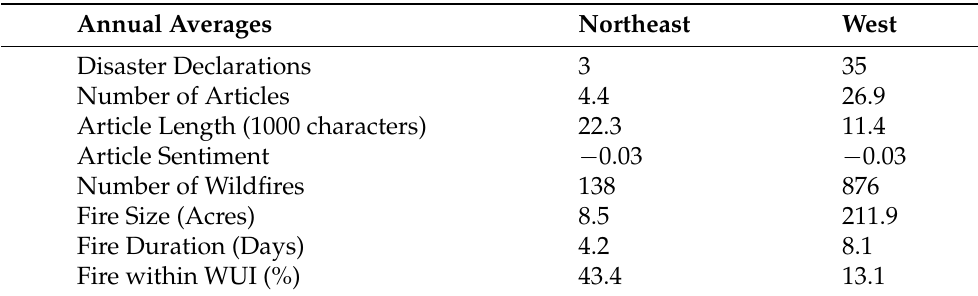
Table A2. Summary statistics of wildfire coverage and events. Generally, the west has more wildfire events and more media coverage than the